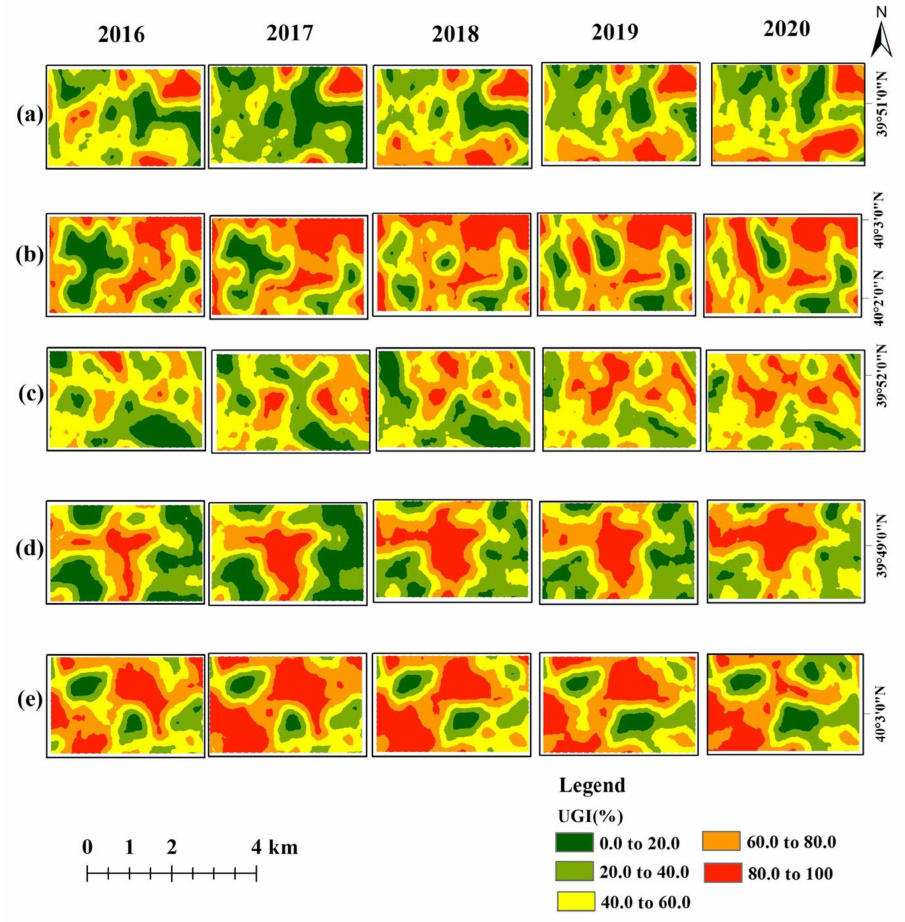
Figure 9. UGI distribution in the five sample regions (a, b, c, d, e in Figure 8f) from 2016 to